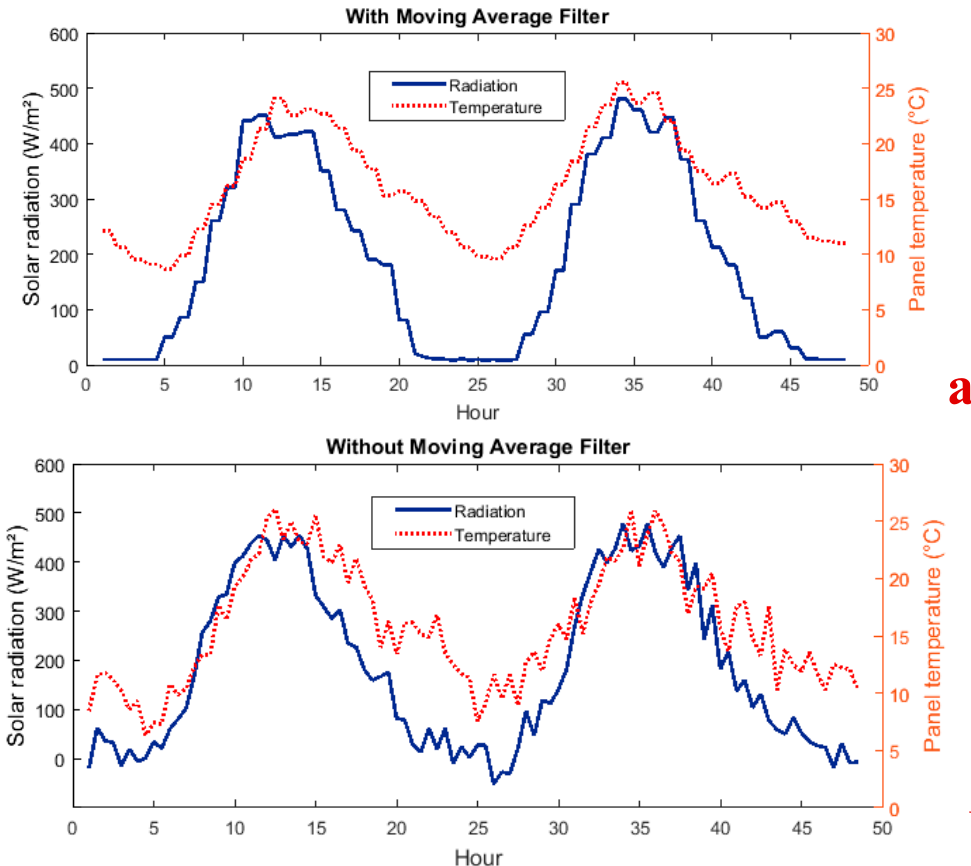
Figure 6. Average hourly temperature and solar radiation distributions throughout April 2018 ( a ) with moving average filter ( b ) without moving average filter. Table 1. The used PV panel’s manufacturer